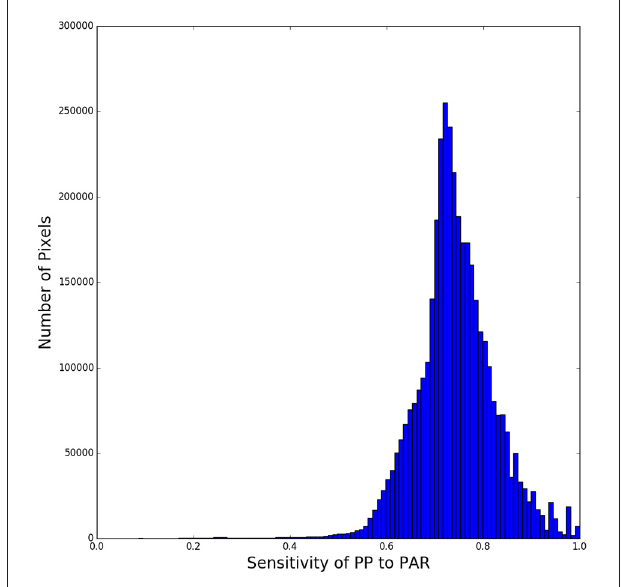
FIGURE 4 | Histogram of relative change in daily production for a 50% reduction in surface irradiance on all sea pixels in Figure 3E